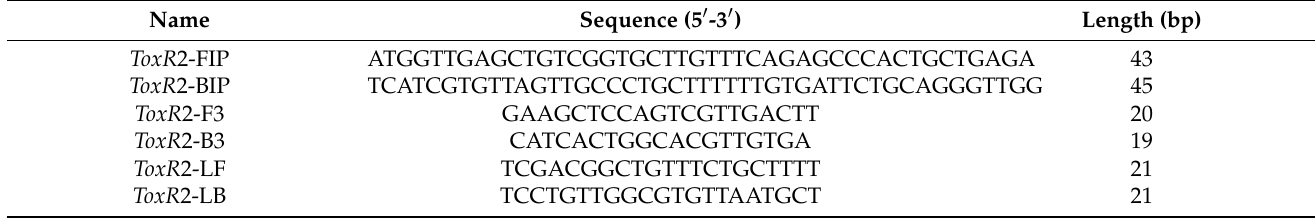
Table 1. The sequences and lengths of the inner, outer and loop primers based on the toxR gene of V. harveyi. The primers were designed using the default parameters of Primer Explorer Version 4 at http://primerexplorer.jp/elamp4.0.0/index.html (accessed on 1 February 2020).